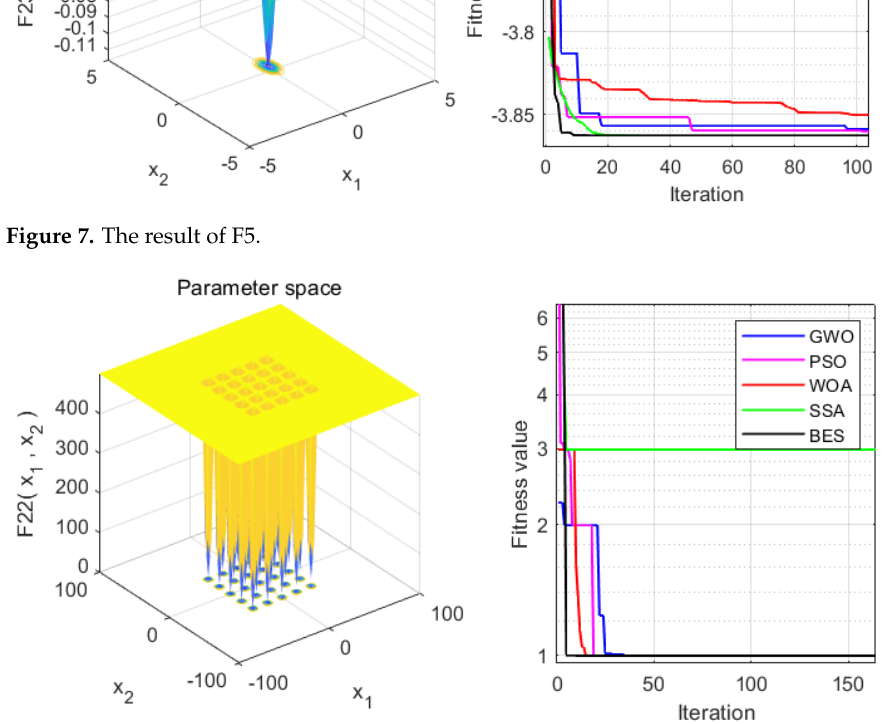
Figure 8. The result of